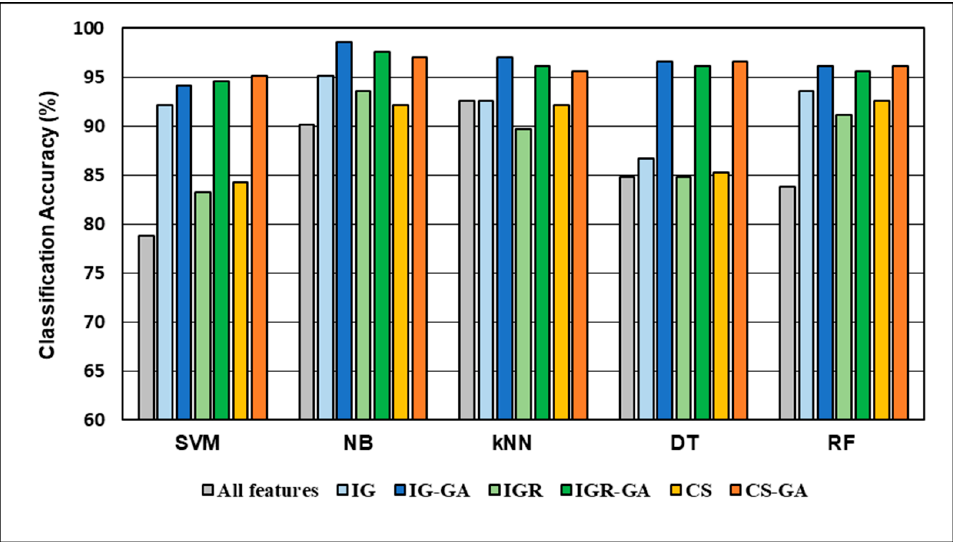
Figure 4. The accuracy comparison of classifiers using all features, the features selected only by filters methods, and the features selected by the proposed hybrid filter-GA methods on the Lung Cancer dataset.